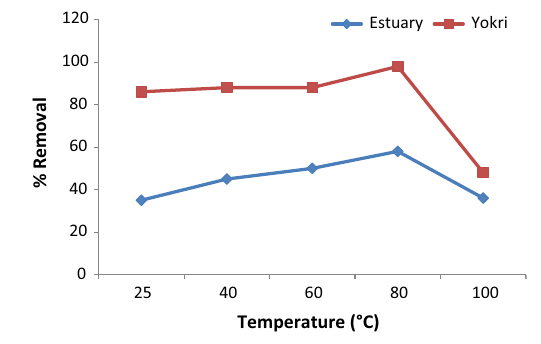
Fig. 7 Effect of temperature on sorption of crude oils onto FBPC